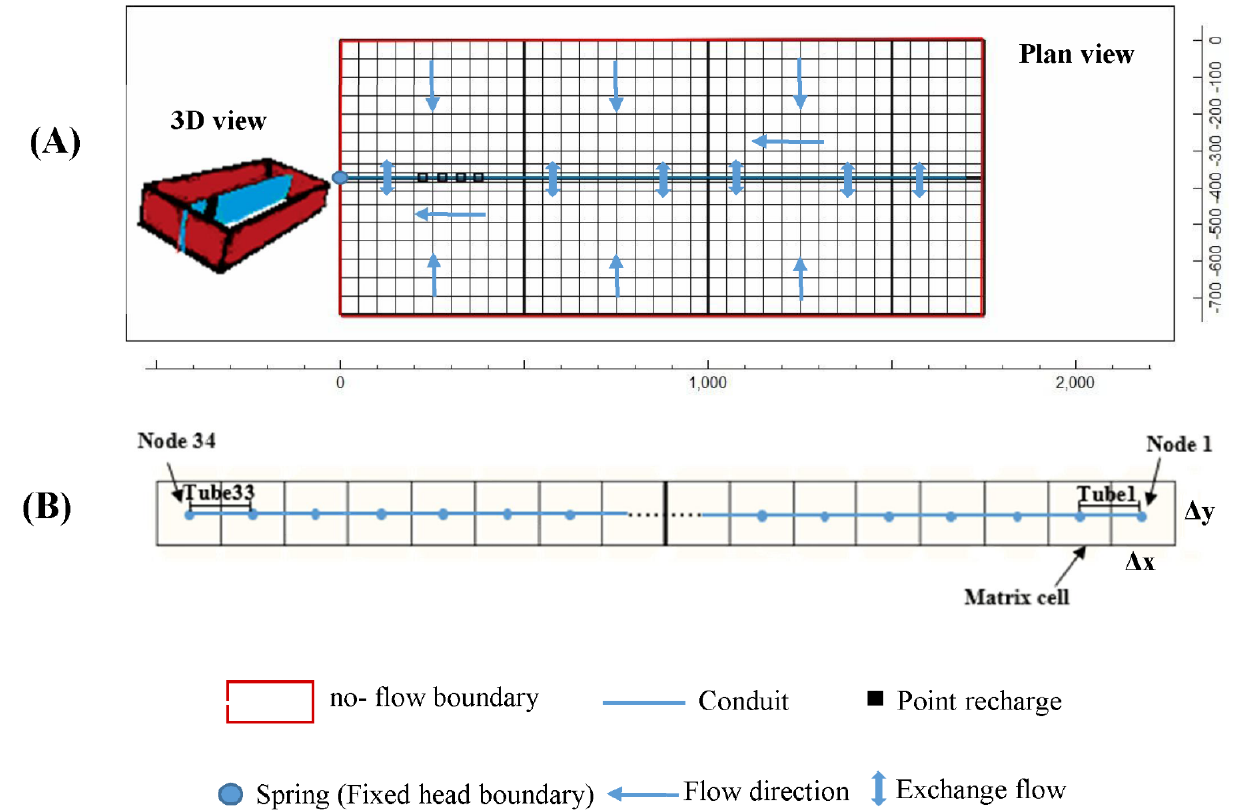
Figure 3. ( A ) The conceptual model with the plan and 3D view used for the simulation. ( B ) The plan view of the number of nodes and tubes in the conduit.